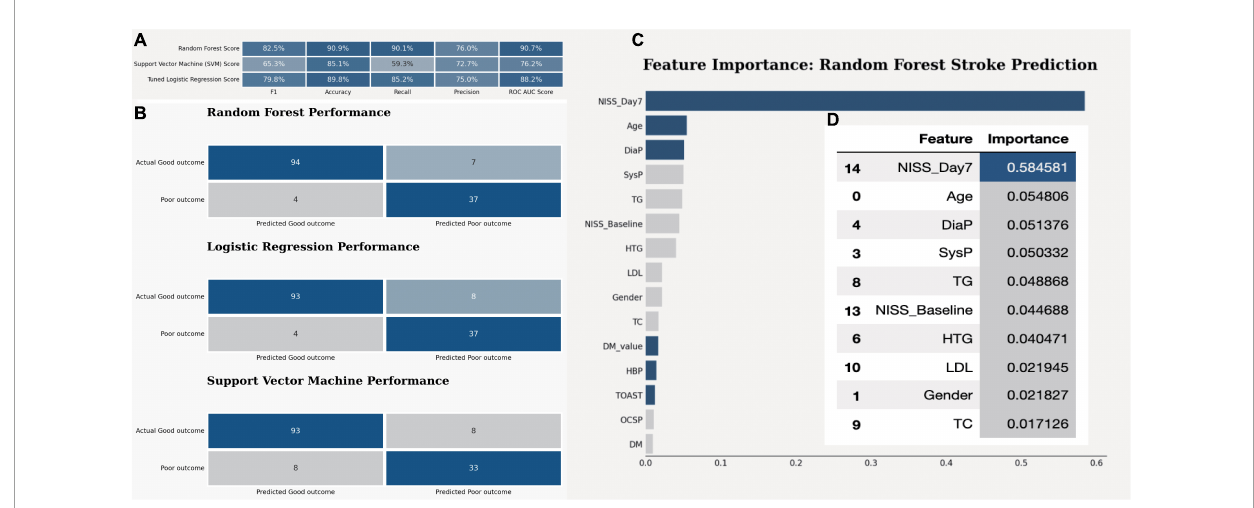
FIGURE1 The model quality comparison among three ML models. (A) The F1 score and accuracy score in three models in the testing dataset. (B) The confusion matrix for three ML models in the testing dataset. (C) The bar plot shows the feature importance in random forest model. (D) The bar quantification for the feature importance in random forest model.